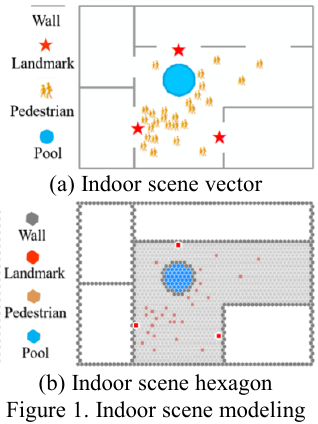
Figure 1. Indoor scene